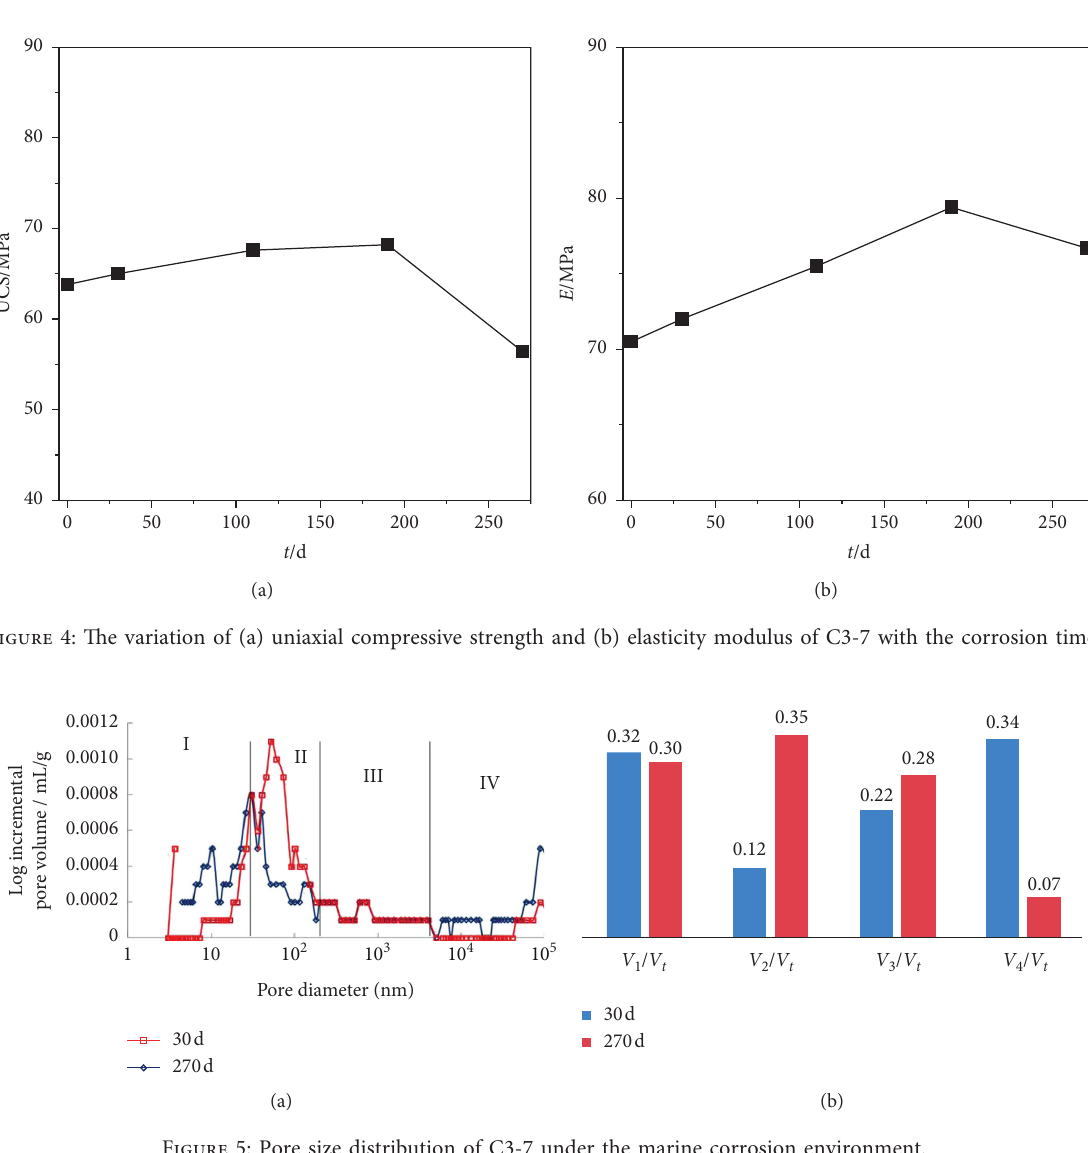
Figure 5: Pore size distribution of C3-7 under the marine corrosion environment.